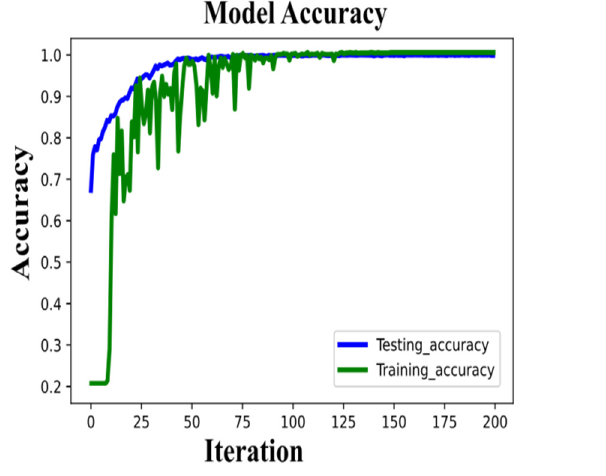
Figure 8. ( a ) The training and testing accuracy of the proposed model. ( b ) The loss history of the proposed model for training and testing set.